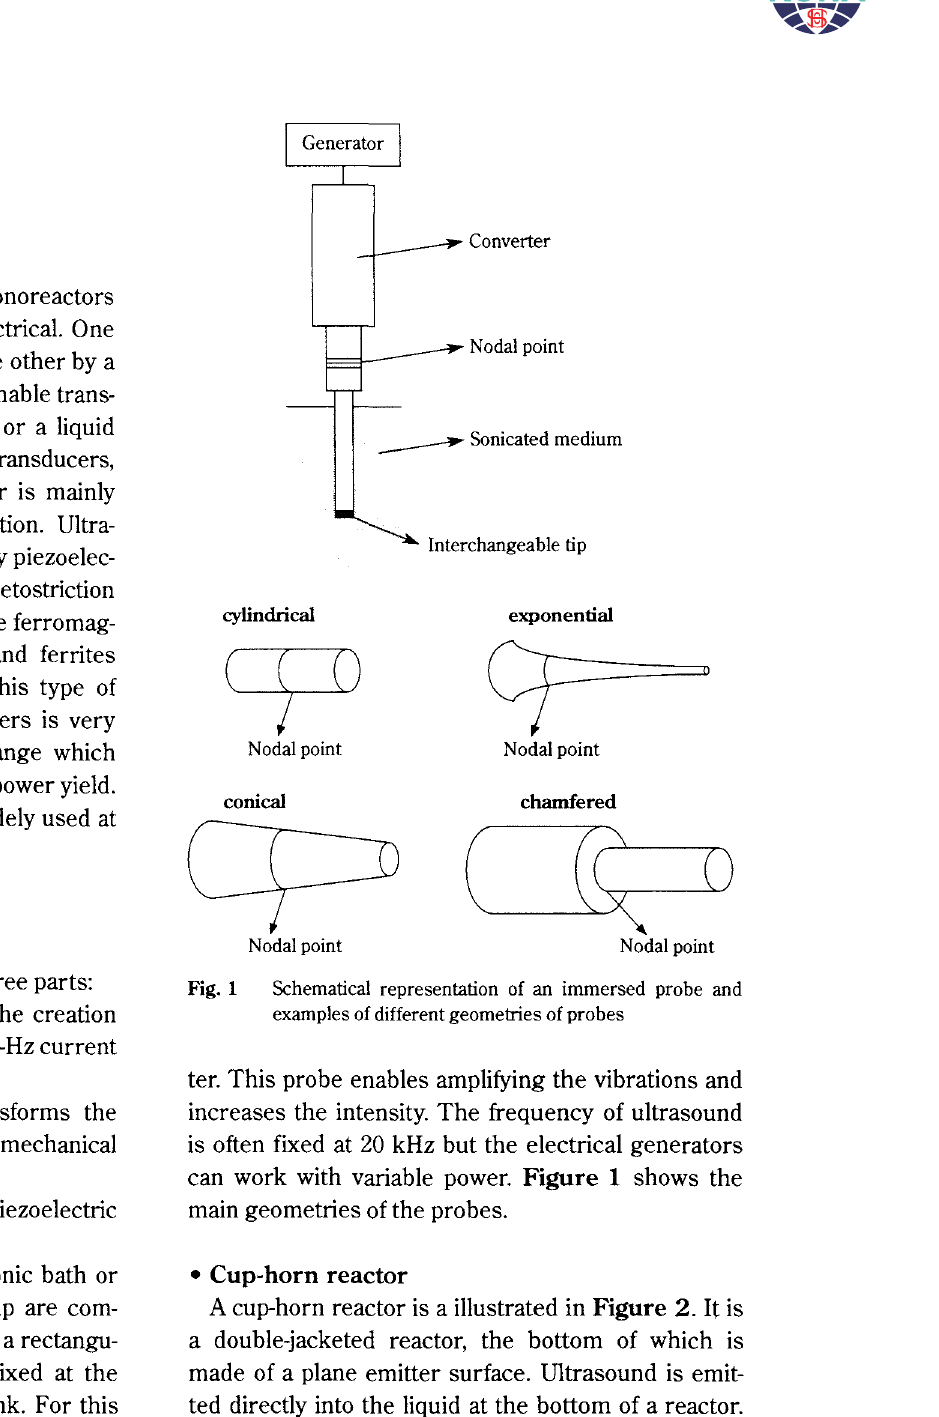
Schematical representation of an immersed probe and examples of different geometries of